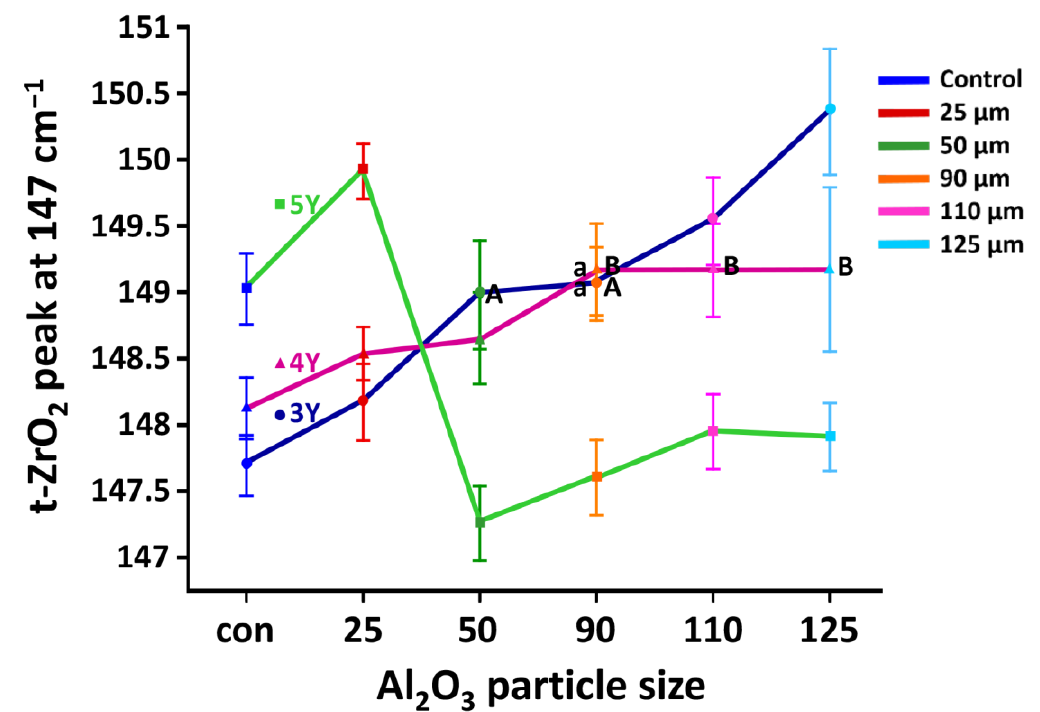
Figure 7. The 147 cm − 1 of the t-ZrO 2 Raman peak shift for each subgroup of three zirconia grades as a function of Al 2 O 3 particle size. Mean values represented with the same uppercase letters (within each zirconia grade) or lowercase letters (within each particle size) are not significantly different based on the results of pairwire comparisons for simple main effects using the Sidak adjustment ( p > 0.05). For 3Y-TZP, the peak shift increased with increasing particle sizes up to 125 µ m ( p < 0.05). The tetragonal peak at 147 cm − 1 shifted to a higher wavenumber up to 90 µ m for 4Y-PSZ ( p < 0.05), while the peak shifted to a higher wavenumber up to 25 µ m for 5Y-PSZ ( p <